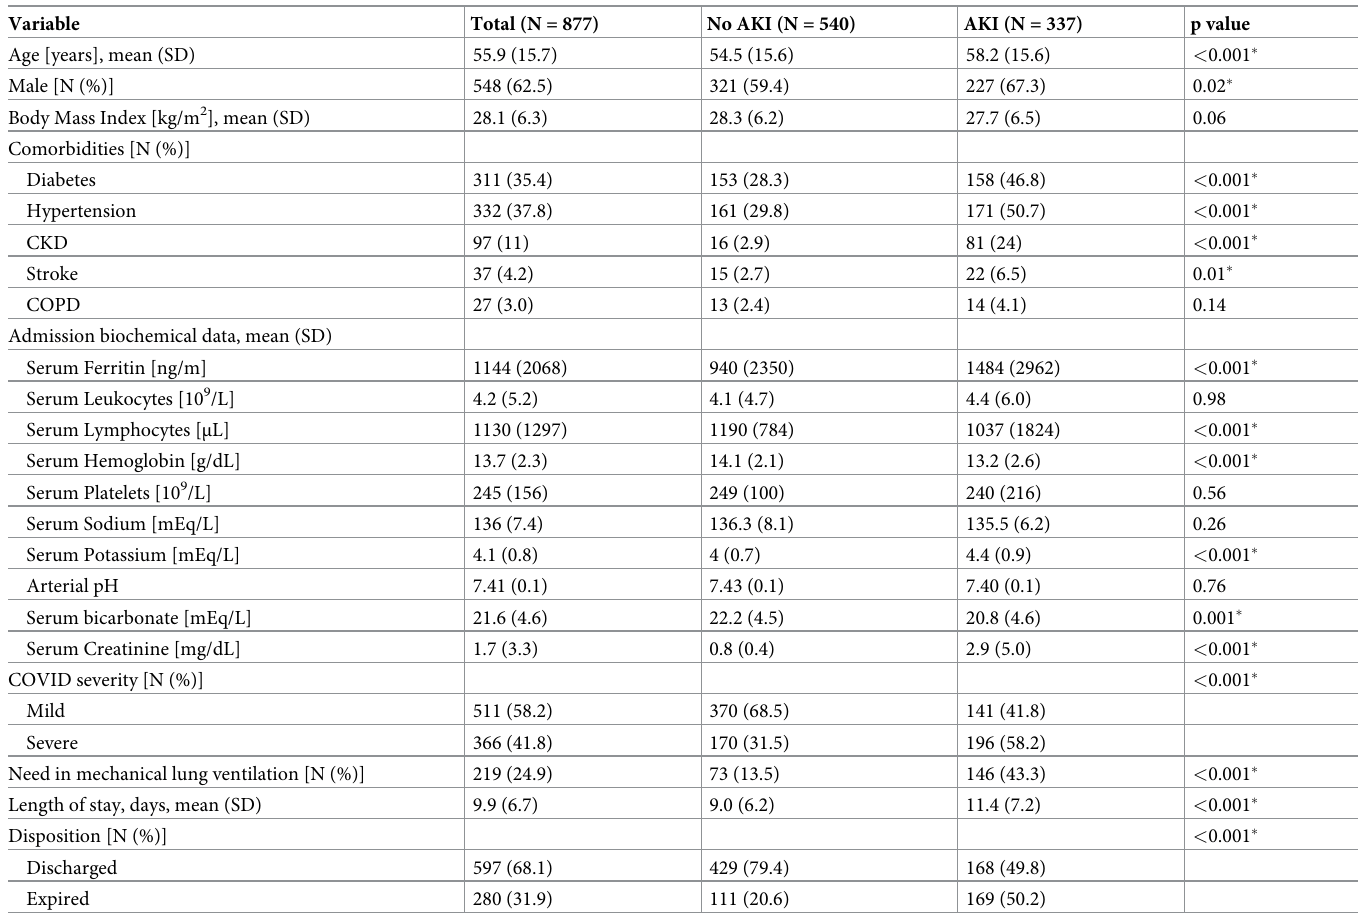
Table 1. Baseline characteristics of the study cohort by AKI and no